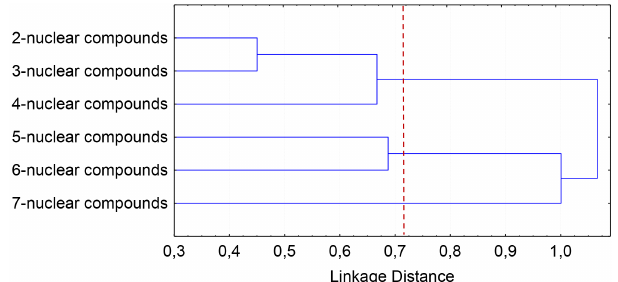
Figure 12. The cluster analysis (complete linkage; 1-Pearson r ) for PAH groups in the investigated soil samples. To the left of the red line, the correlation coefficient is statistically significant ( p < 0 . 05).